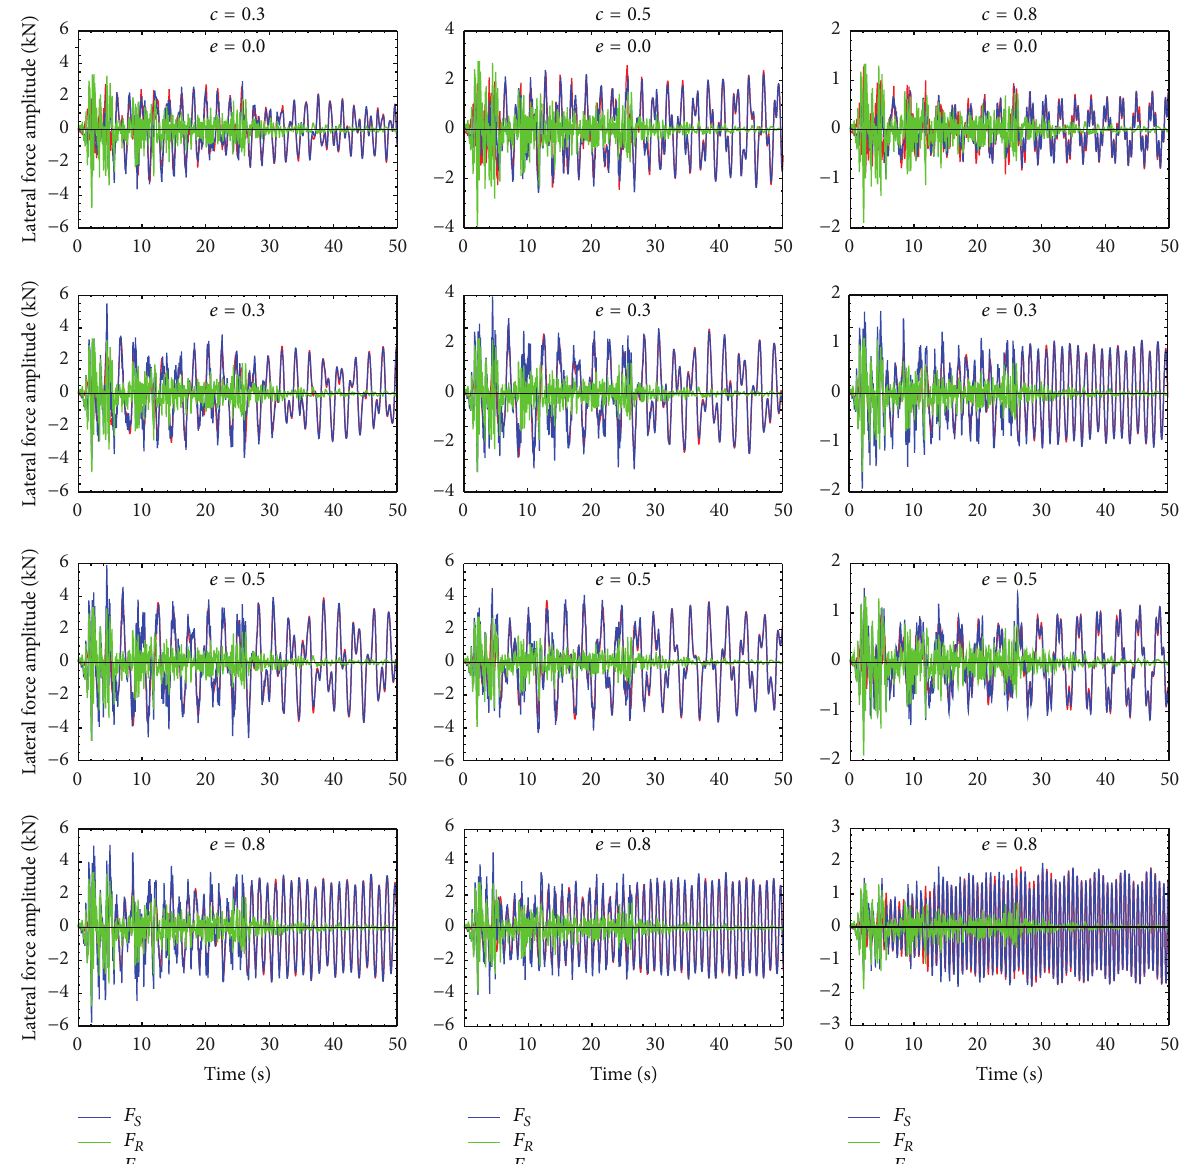
Figure 6: Time histories of the calculated forces of rigid motion, sloshing forces, and total